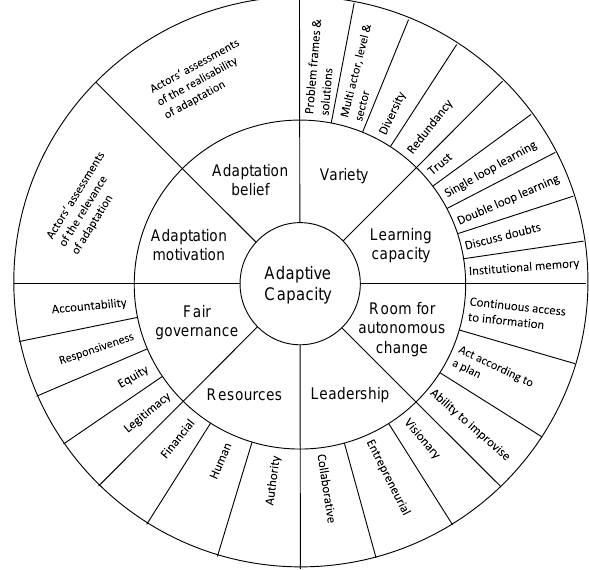
Fig. 1. Extended Adaptive Capacity Wheel – including two psychological dimensions.